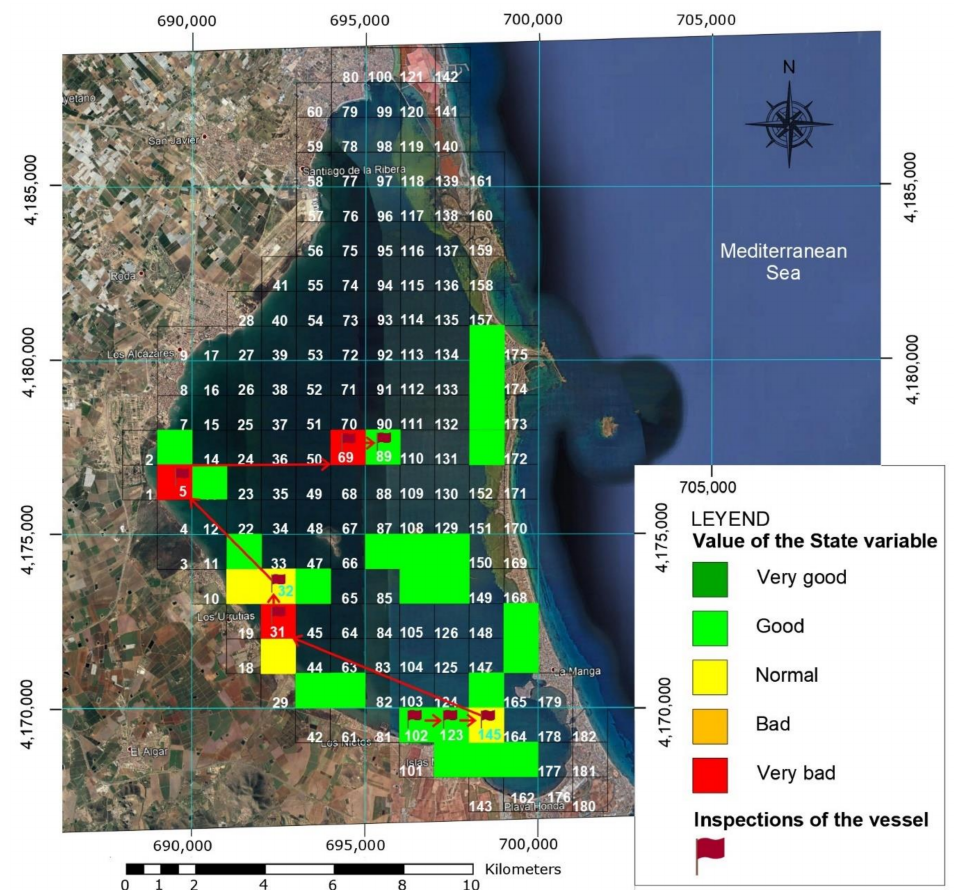
Figure 16. Box colour scheme. Boxes with a number and colour are the ones explored and therefore have updated data. The coloured squares without numbers are previously collected values. Uncoloured boxes are those for which no data are available and require monitoring. The values in red (alarms) simulate possible spills or